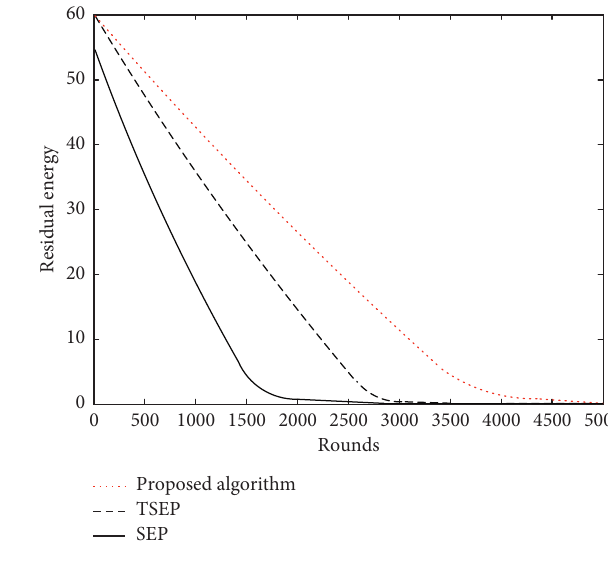
Figure 7: Residual energy with a single zone.